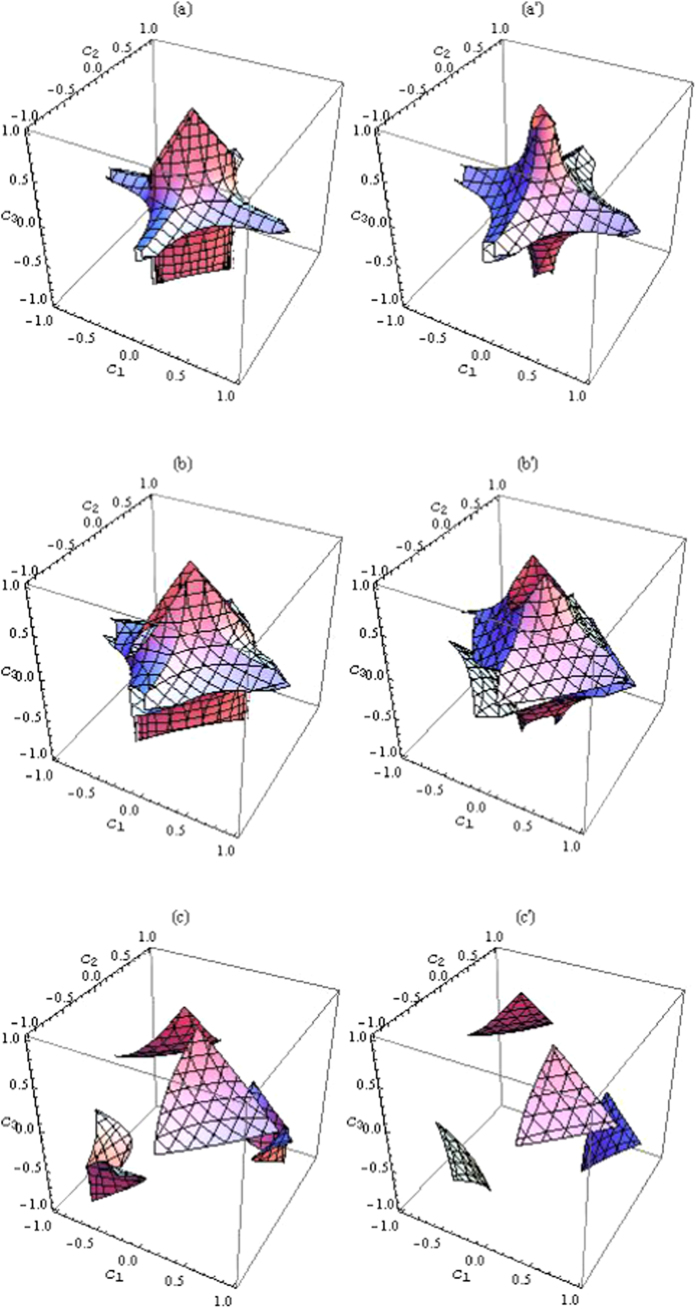
The surfaces of constant DN and  as a function of c1, c2 and c3 for: (a) DN = 0.05, (b) DN = 0.1 and (c) DN = 0.3; (a′) , (b′)  and (c′) .